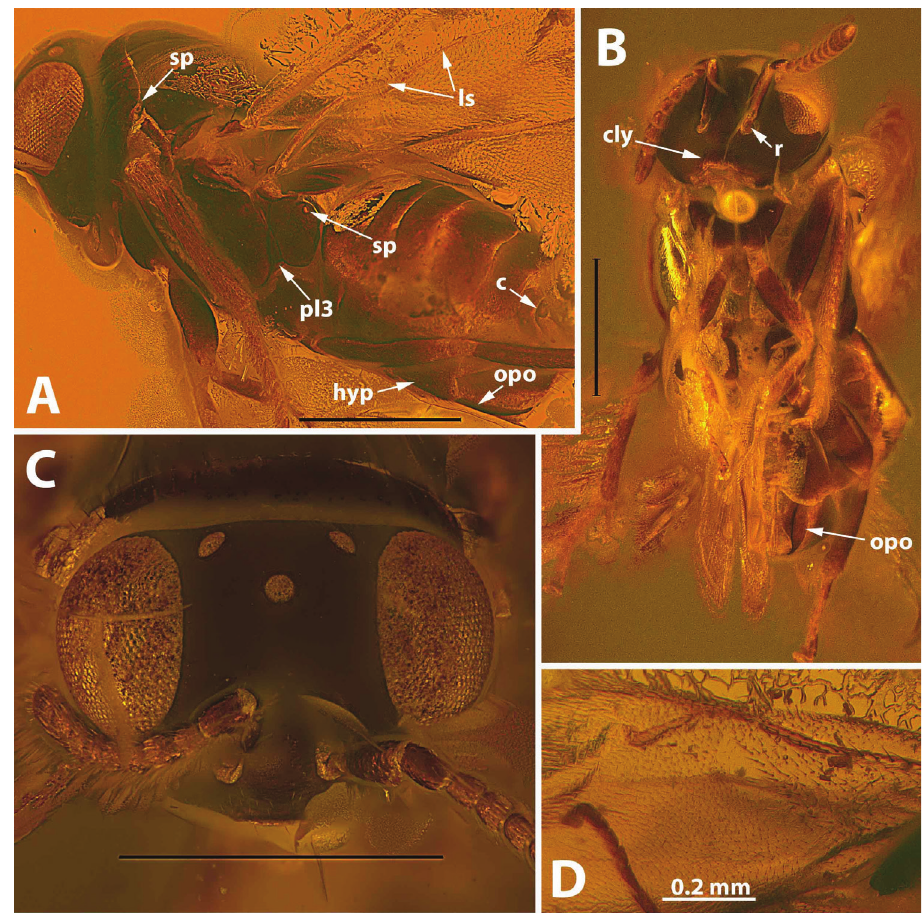
Figure 3. S. glaesaria , female, holotype A habitus, left lateral B habitus, ventral C head, frontal D fore- wing venation (cly – clypeus, hyp – hypopygium, ls – line of setae, opo – outer plates of ovipositor, pl3 – metapleuron, r – radicle, sp – spiracle) number of mandibular teeth not visible; maxillary palpi 4-seg- mented; labial palpi 3-segmented (Fig. 5D). Scale bars: 0.5 mm ( A–C to anterior ocellus, in dorsal view anterior ocellus at equal distance from occiput margin and from margin of scrobal depression; interantennal projection small but visible in lateral view (Figs 1C, 2C); toruli located at level of lower margin of eyes (Figs 1B, 5D); distance between toruli equal to distance between lower margin of torulus and oral margin, about twice width of torulus, about 0.3× length of malar space; malar space with complete malar sulcus (Fig. 5D), slightly shorter than height of eye, about equal to width of mouth; clypeus widely emarginated with long lateral margins, about twice as broad as long, with sharp ventrolateral angles, and with row of setae (Figs 1B, 5D); mandibles wide (Figs 1B, 5D), Antenna . Geniculate, 11-segmented, without differentiated anelli, with 6 funicu- lar segments and with 3-segmented clava; radicle short, about 2–2.5× as long as broad